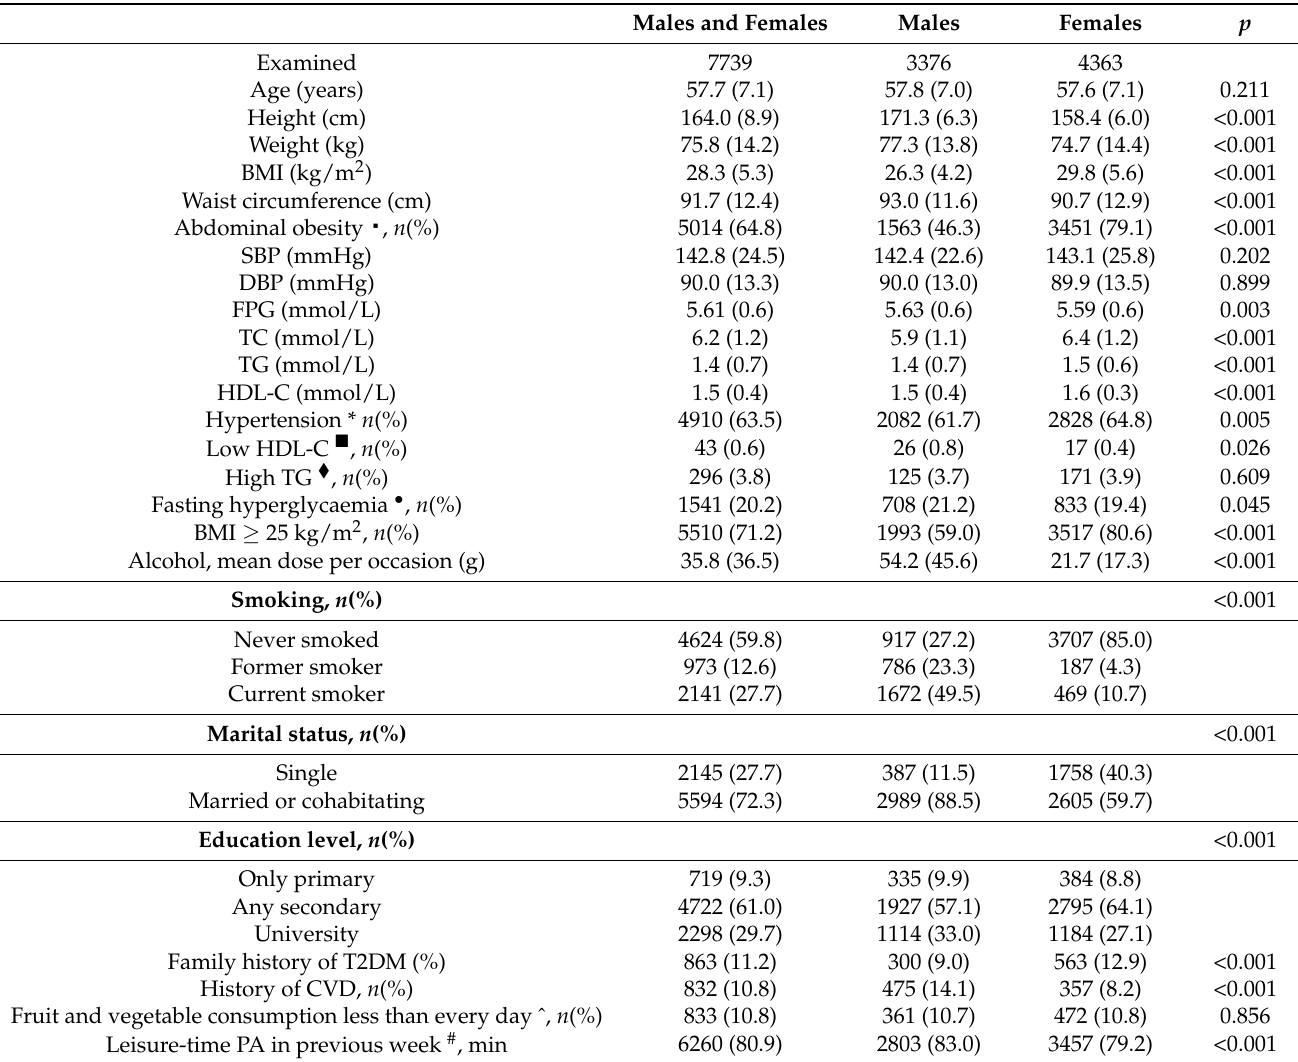
Table 1. Characteristics of the studied population sample (aged 45–69 years old at baseline, n = 7739).